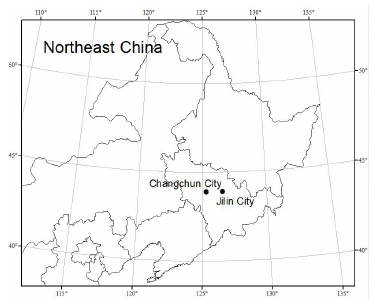
Figure 1. the location of sampling